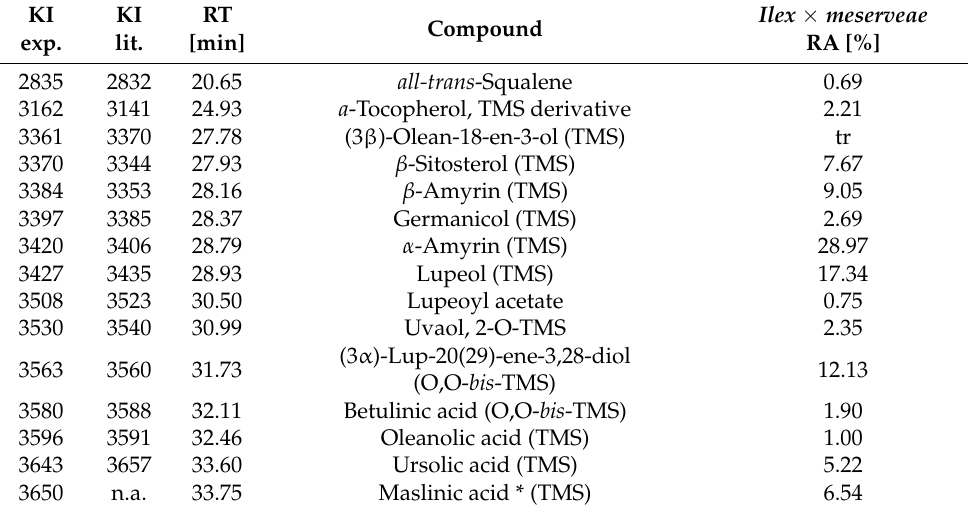
Table A1. GC-MS profile of triterpenoid fraction of Ilex meserveae